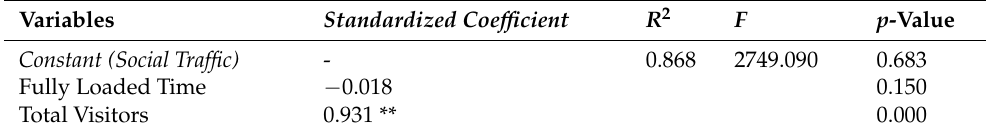
Table 6. Second hypothesis’